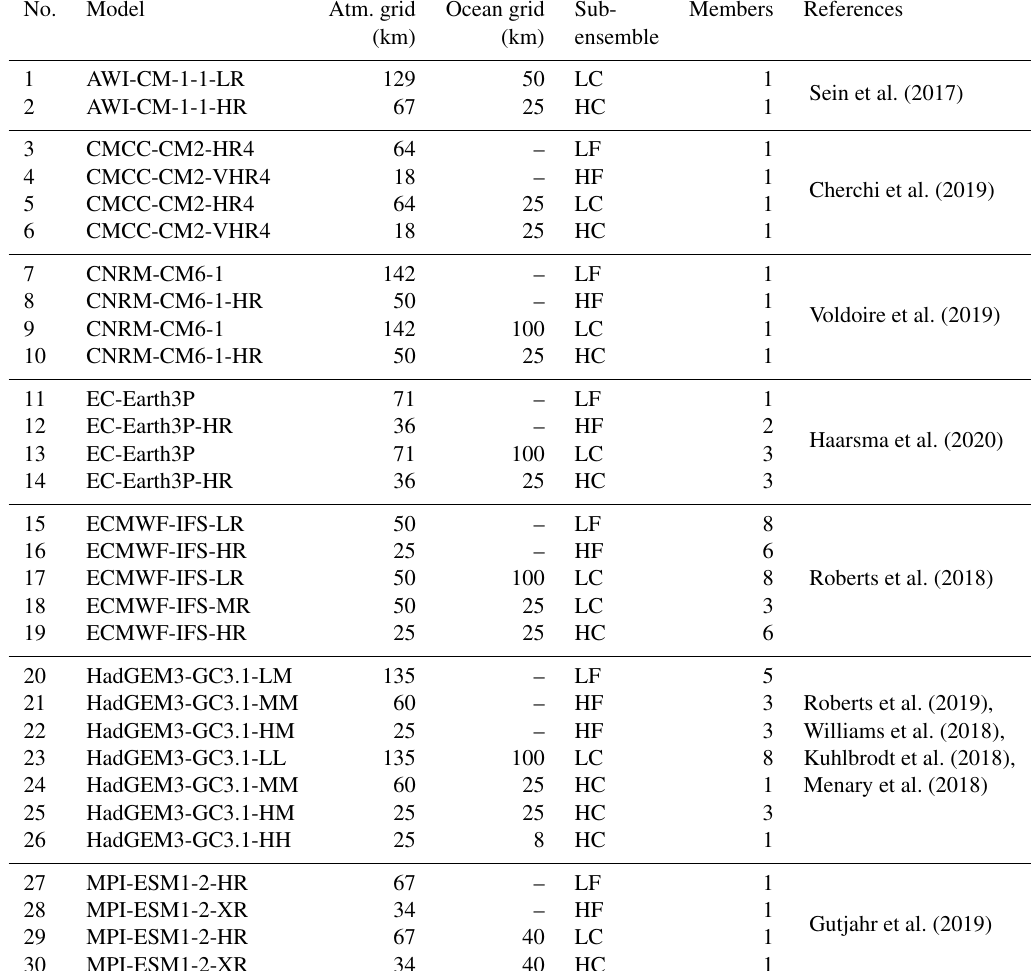
Table 1. PRIMAVERA models and simulations. Columns detail the model name, the atmosphere grid spacing at 50 ◦ N, nominal ocean grid spacing, a sub-ensemble indicator (“LF” – low-resolution forced (AMIP), “LC” – low-resolution coupled, “HF” – high-resolution forced, and “HC” – high-resolution coupled), the number of ensemble members used in this study, and model documentation references.